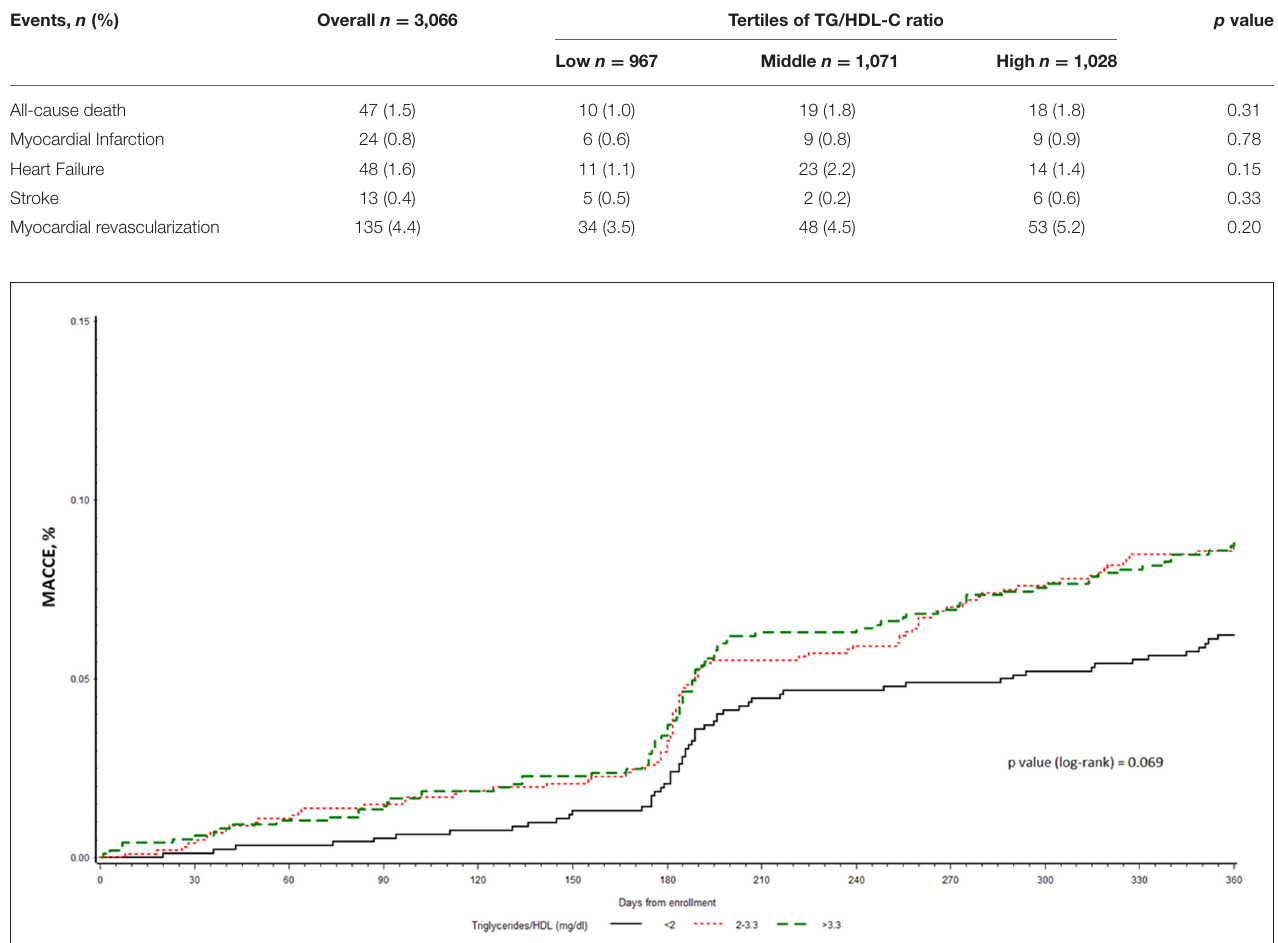
TABLE 2 | Single components of MACCE at 1 year.